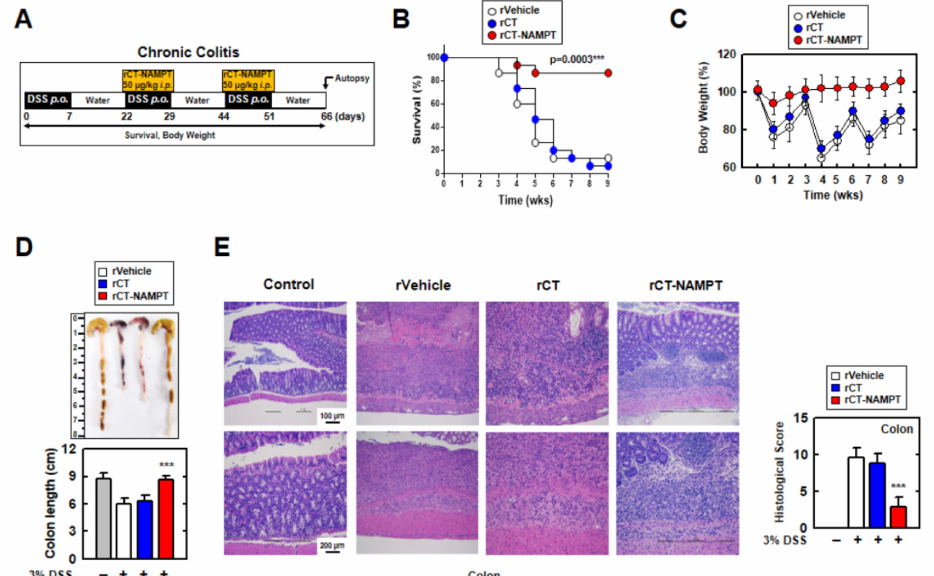
Figure 7. rCT-NAMPT relieves chronic DSS-induced colitis in a mouse model. ( A ) Scheme of the chronic colitis model subjected to 3% DSS with rCT-NAMPT (50 µ g/kg). ( B ) Mice survival was tracked for 9 weeks, and mortality was calculated for n = 15 mice per group. The statistical differences between the rVehicle-treated animals are noted (log-rank test). The data come from two different experiments that yielded comparable results. ( C ) Weight loss of rVehicle, rCT or rCT-NAMPT in mice ( n = 15). ( D ) Image (upper) and length (lower) of colon in 3% DSS-induced chronic colitis mice with rVehicle, rCT or rCT-NAMPT. ( E ) H&E staining of the colon (left) ( n = 8): a representative image. H&E staining was used to evaluate histopathology scores in 3% DSS-induced chronic colitis mice with rVehicle, rCT, or rCT-NAMPT. The Student’s t -test with the Bonferroni adjustment was used to establish statistical significance when compared to rVehicle (*** p <